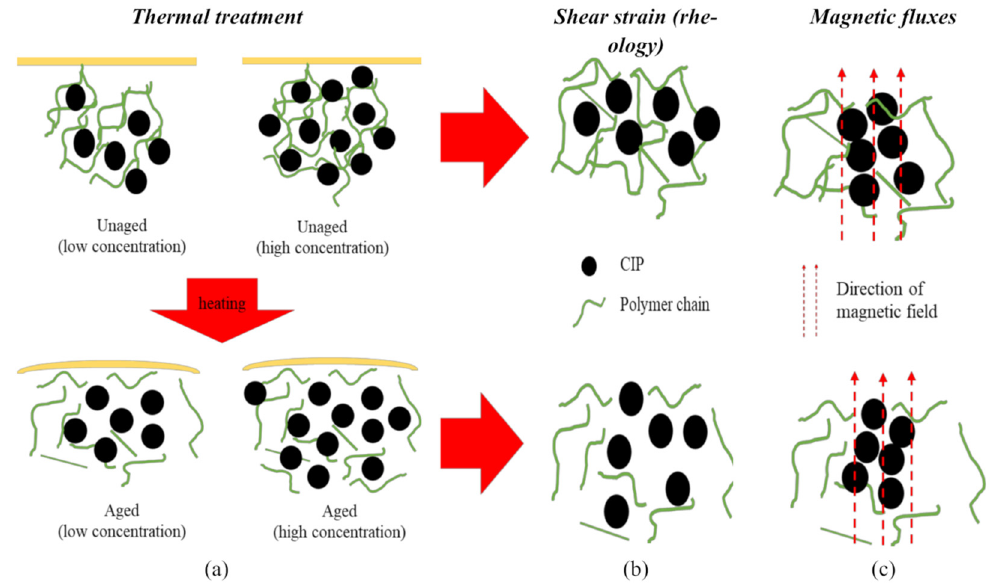
Figure 6. Matrix ‐ filler interactions in unaged and aged SR ‐ MRE samples under different external